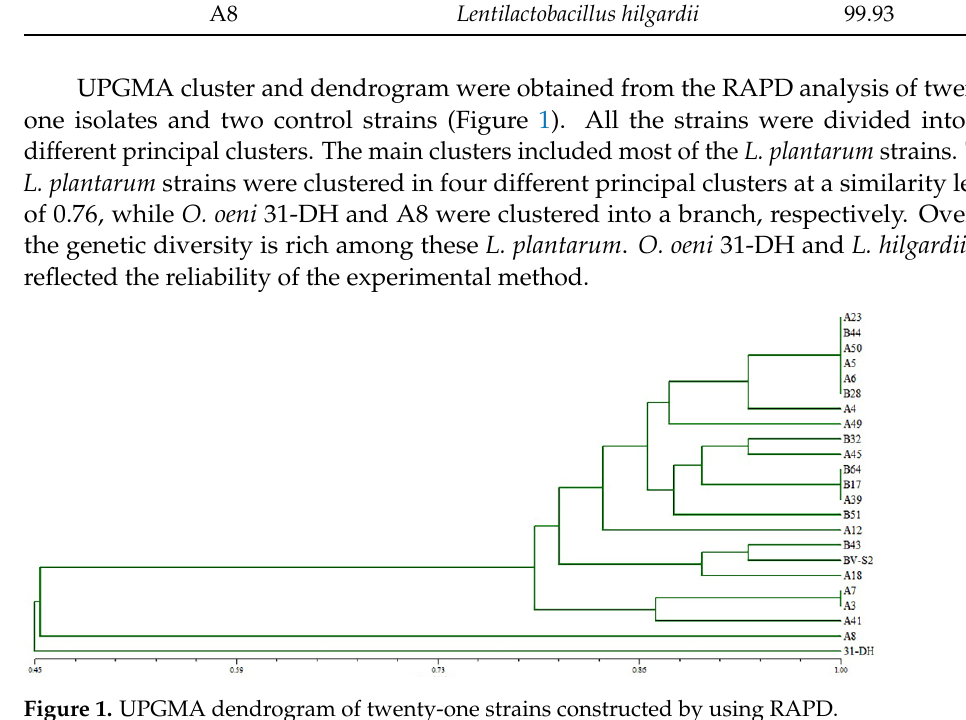
Figure 1. UPGMA dendrogram of twenty-one strains constructed by using PARD